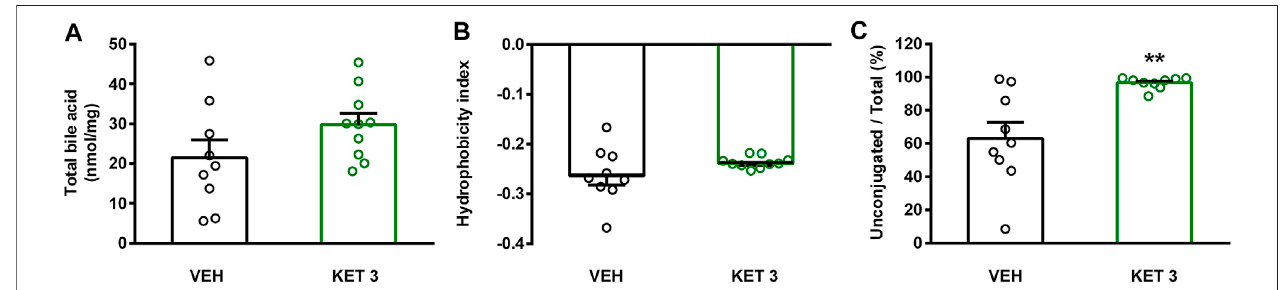
FIGURE 6 | The effect of four-week vehicle (VEH) or ketorolac treatment (KET, 3 mg/kg) on small intestinal total ileal bile acid level (A) , mean hydrophobicity index (B) , and ratio of conjugated to total ileal bile acids (C) . Circles represent the data of each rat, bars indicate the mean + SEM. For statistical analysis Student ’ s t test was used, n (cid:2) 9 – 10/group. ** p < 0.01 compared to vehicle-treated group.